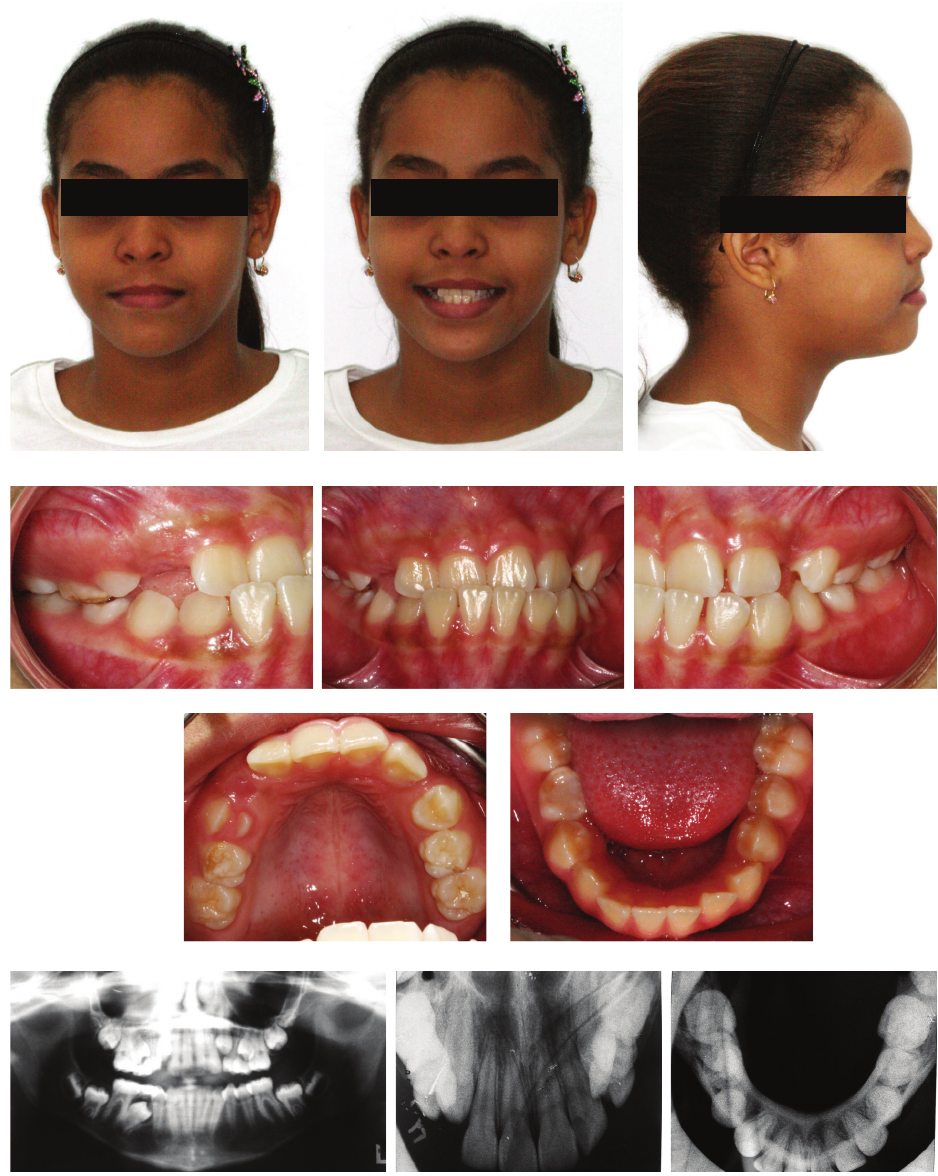
Figure 1: Pretreatment